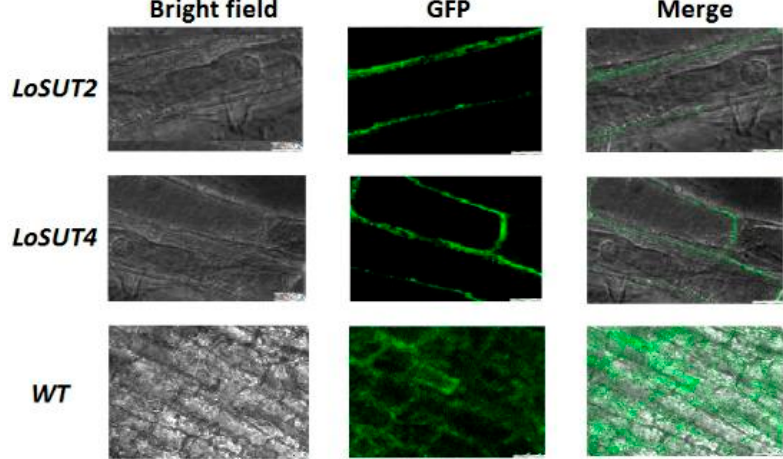
Figure 13. Subcellular localization of LoSUT2 and LoSUT4 in onion epidermis. SUT genes expressed the GFP-highlighted position of the GFP-highlighted position of proteins.